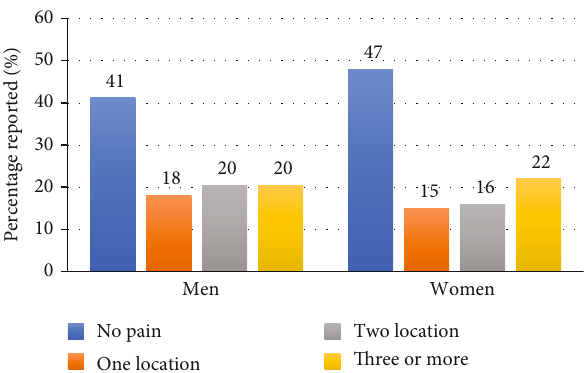
Figure 2: Number of painful sites by sex.